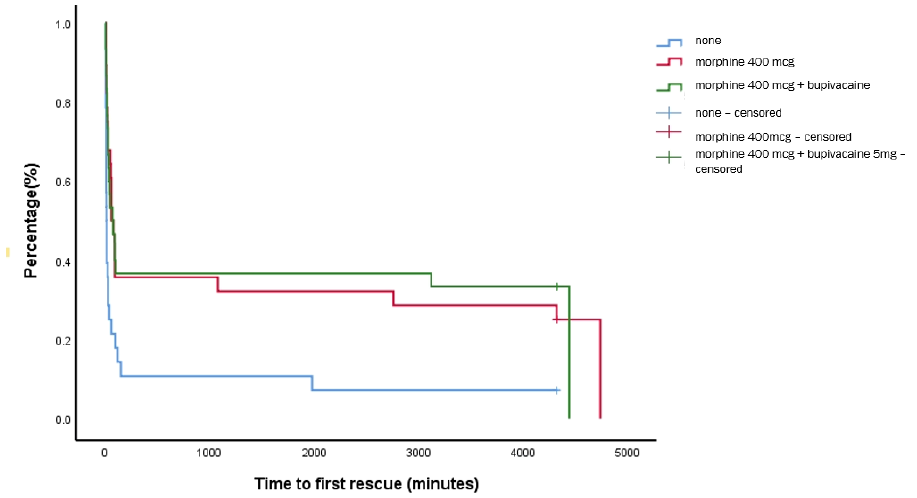
Figure 2. Kaplan–Meier analysis of the time to first rescue analgesic. Figure 2. Kaplan – Meier analysis of the time to first rescue analgesic.